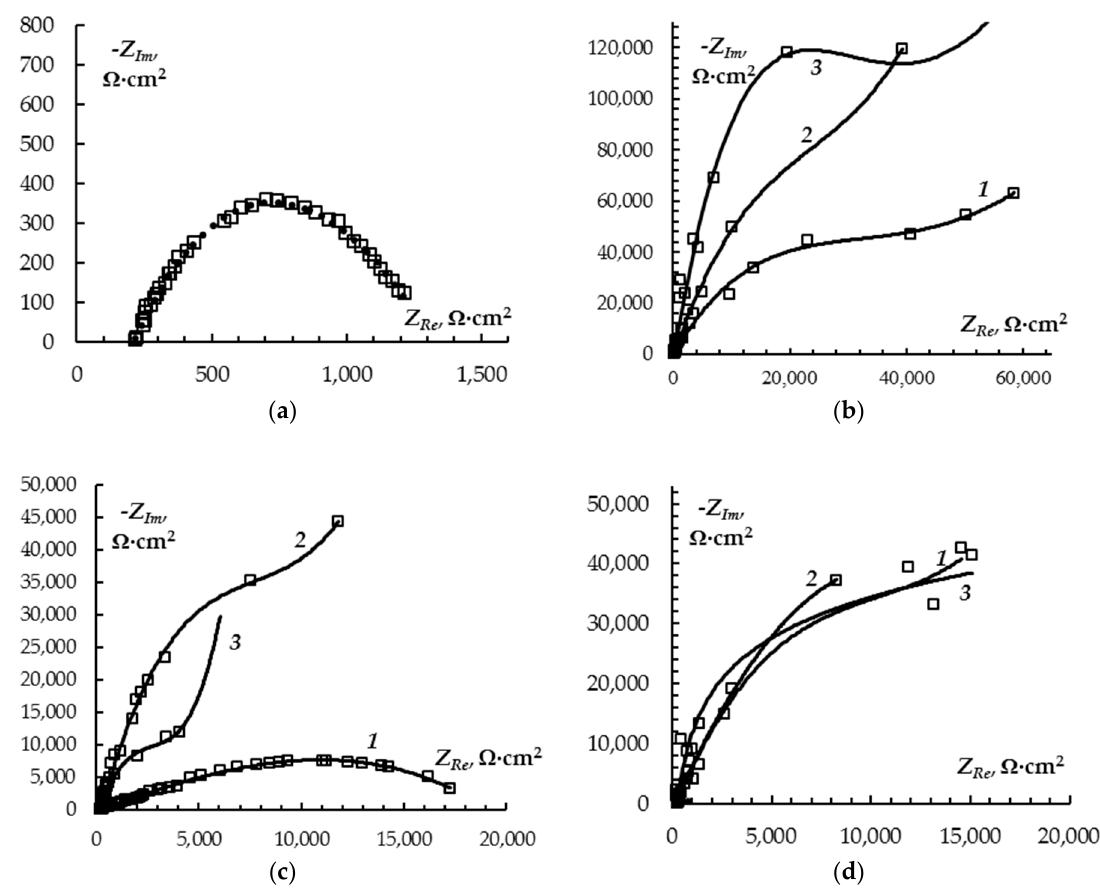
Figure 4. The Nyquist diagrams of brass in borate buffer (pH 7.4) + 10 mM NaCl without an inhibitor ( a ), in the presence of 3-mercaptopropyl-5-amino-1 H -1,2,4-triazole ( b ), 3-mercaptobutyl-5-amino- 1 H -1,2,4-triazole ( c ) and 3-mercapto(3-methylbutyl)-5-amino-1 H -1,2,4-triazole ( d ) at concentrations of 0.01 ( 1 ), 0.10 ( 2 ), and 1.00 mM ( 3 ).